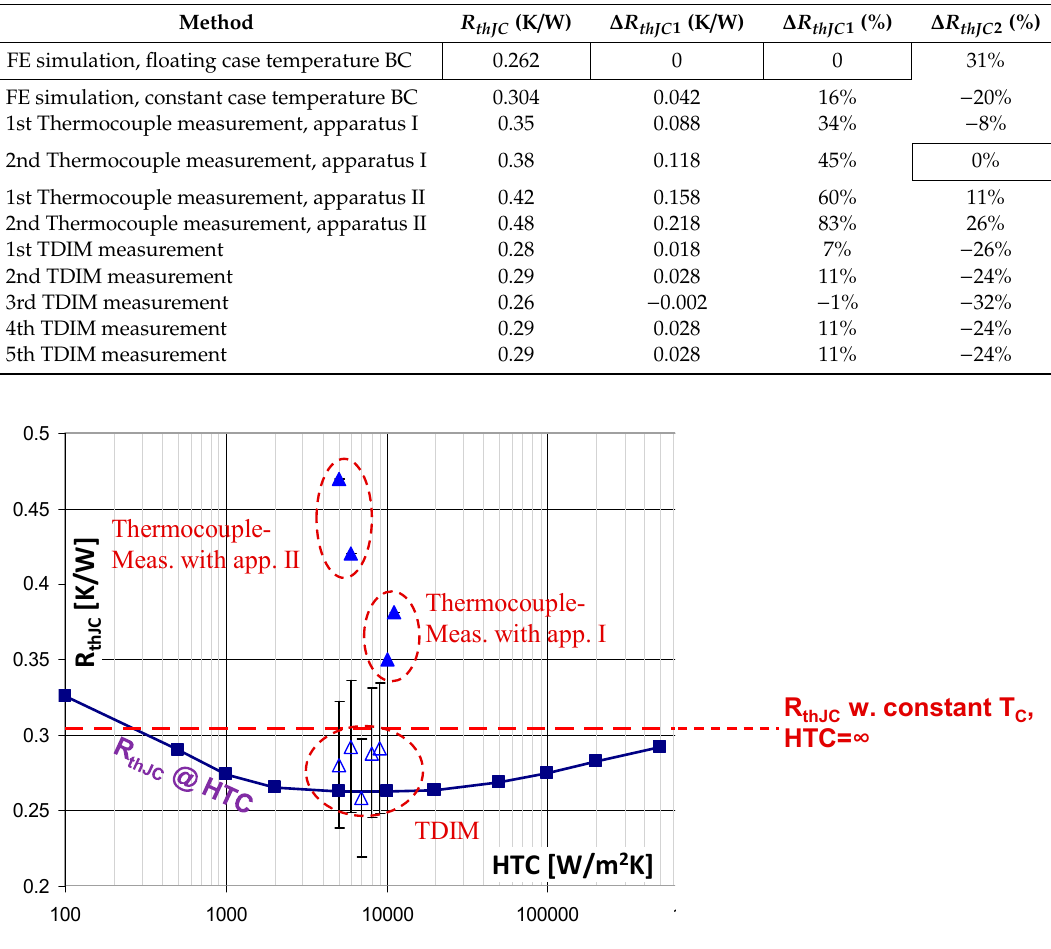
Figure 19. Comparison study at Infineon from Reference [22] and redrawn. The heat transfer coefficient (HTC) of the cold plate may vary within a certain range, and this is illustrated by fictive HTC values chosen for the abscissae of the measurement points. The ordinates are actual measured values (Table 3).